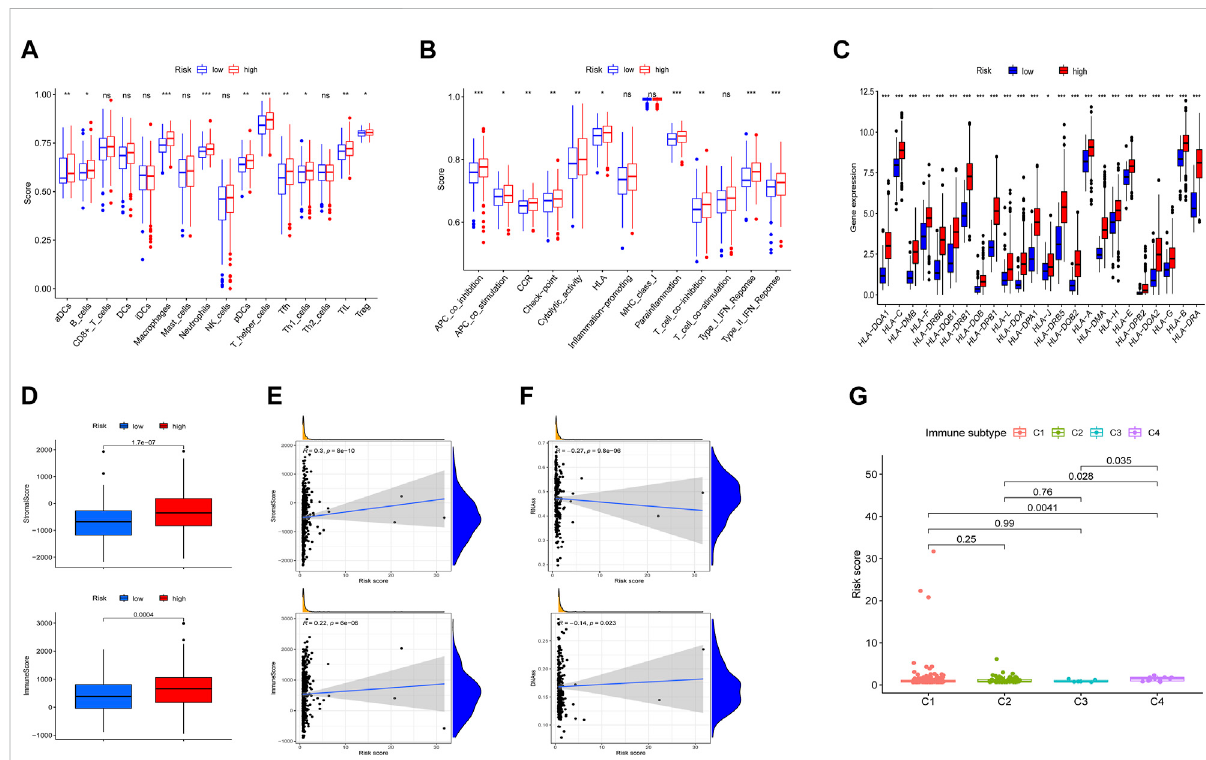
FIGURE 5 Situation of immune cell in fi ltration in high-risk and low-risk groups. (A,B) Comparison of the 16 tumors immune related cells and 13 immune-related functions. (C) ThelevelsofHLA-relatedgeneexpression. (D) ComparisonofESTIMATESscore,Immunescore,andStromalscore. (E,F) Associationbetween riskscoreandESTIMATESscore,Immunescore,Stromalscore,RNAss,andDNAss. (G) Comparisonoftheriskscoreinfourimmunein fi ltrationsubtypes.* p < 0.05, ** p < 0.01, *** p < 0.001. ns, not signi fi